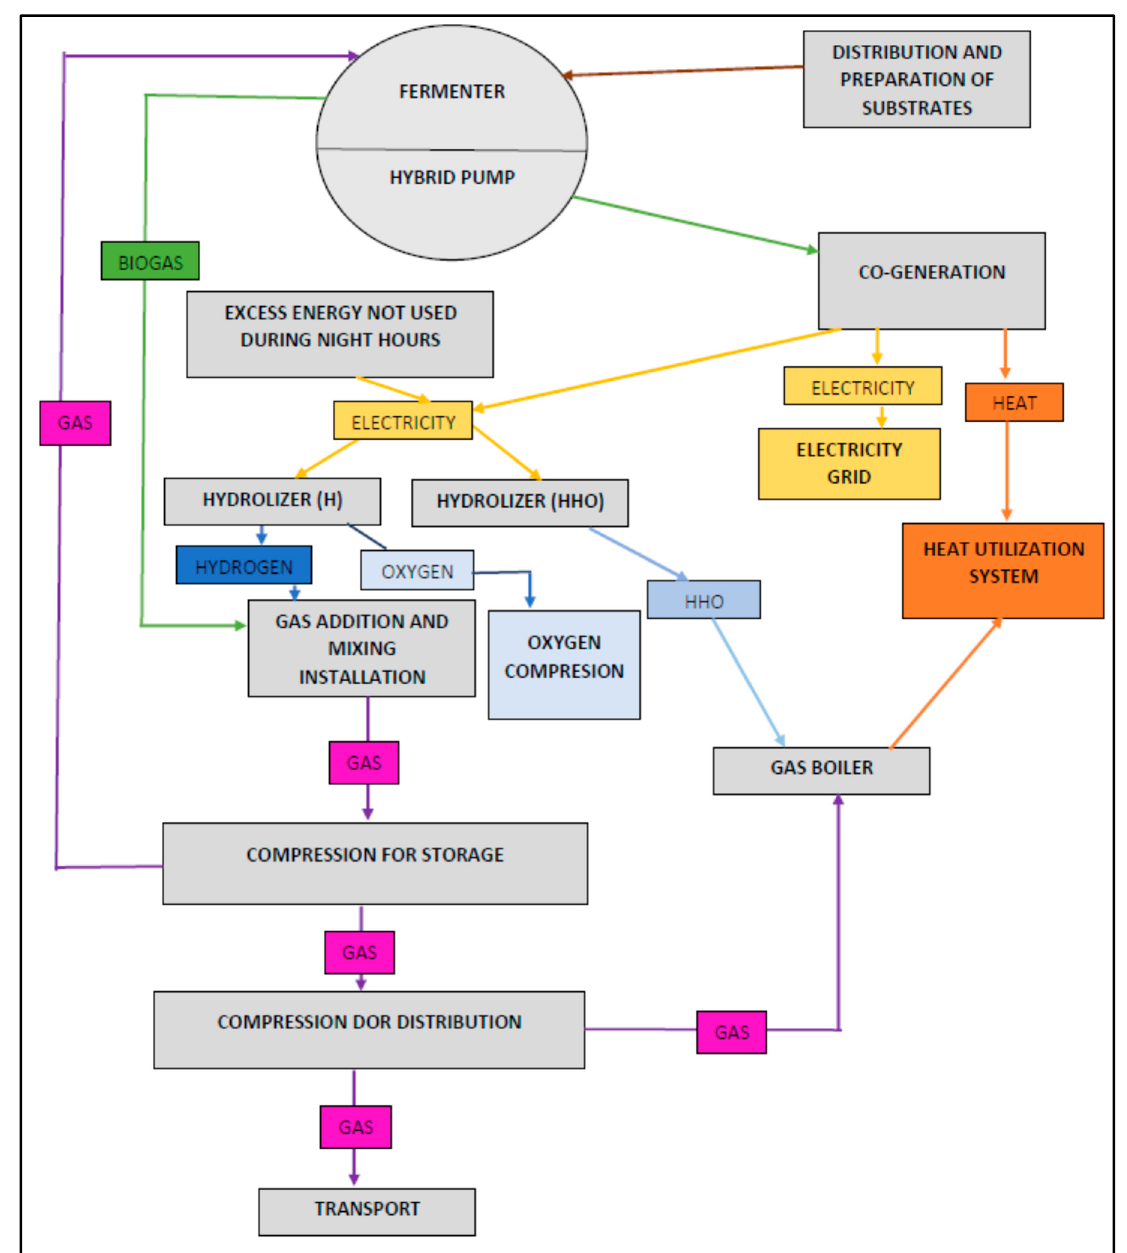
Figure 4. Gas and energy cycle scheme .